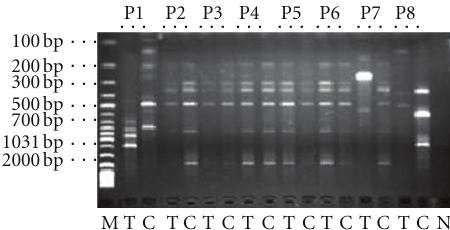
Figure 1: The amplified result of eight primer combinations. Notes: M, Marker; T, Treatment; C, Control; B, Blank or negative control; P1–P8, primer